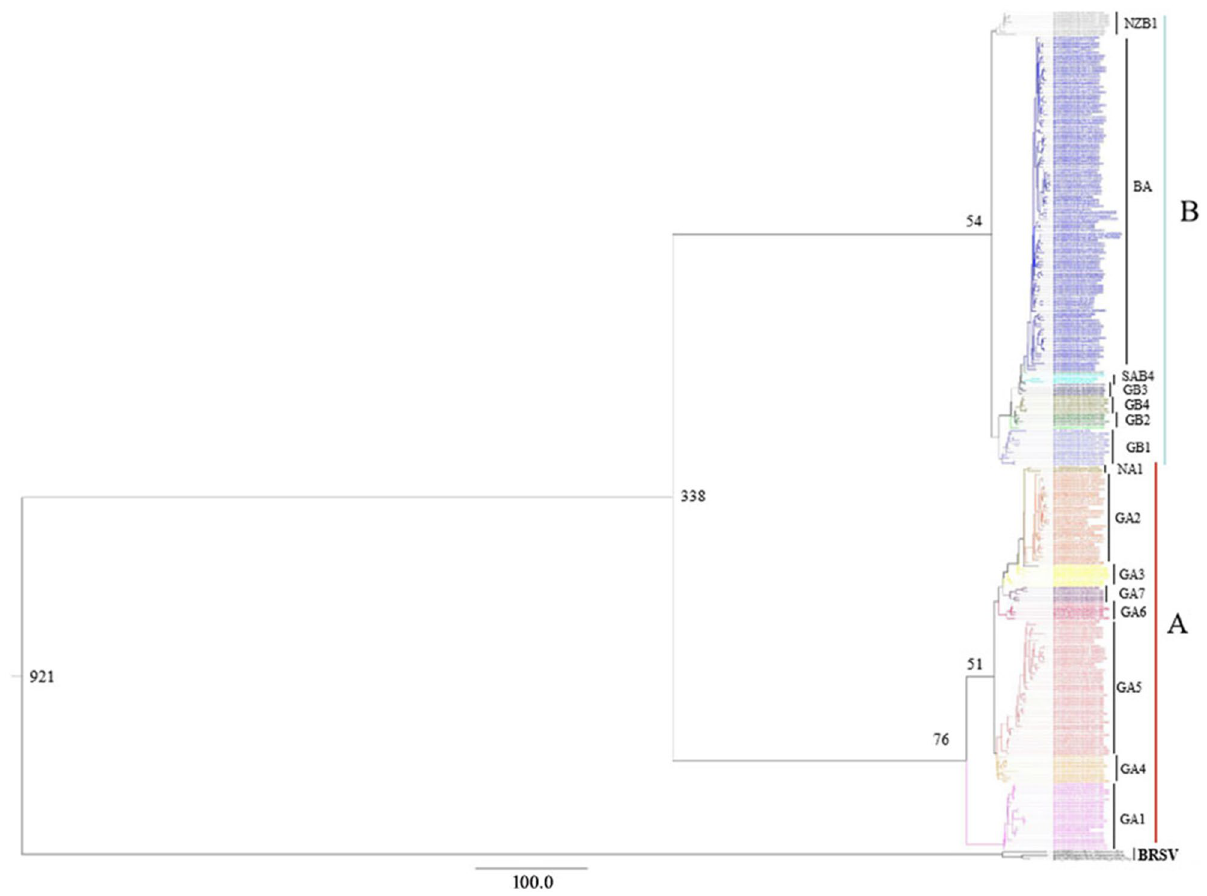
Figure 2. Bayesian Markov Chain Monte Carlo tree of the complete G genes of RSV-A, RSV-B and BRSV. The estimated time of the MRCA of the major nodes and the names of different viral clades were marked in the graph. The results showed that RSV-A and RSV-B diverged from their common ancestor 338 years